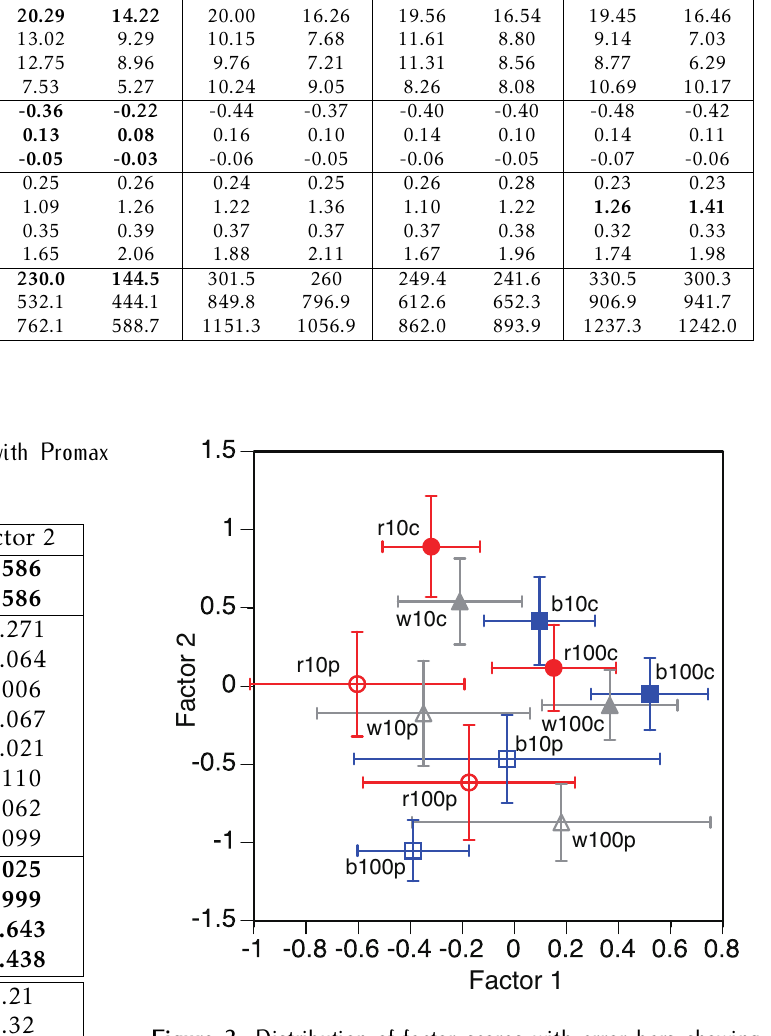
Figure 3. Distribution of factor scores with error bars showing standard